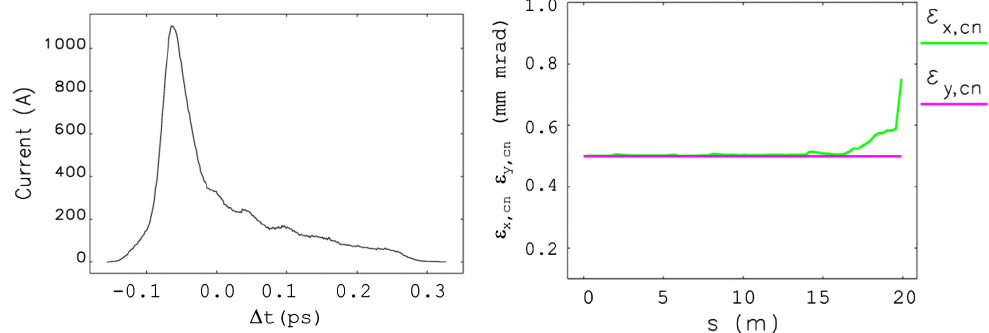
FIG. 5. Results from E LEGANT simulation for current profile at the exit of the CA (left), and projected normalized betatron emittances (right) along the CA. Slice emittances (not shown) are preserved at the injection level.